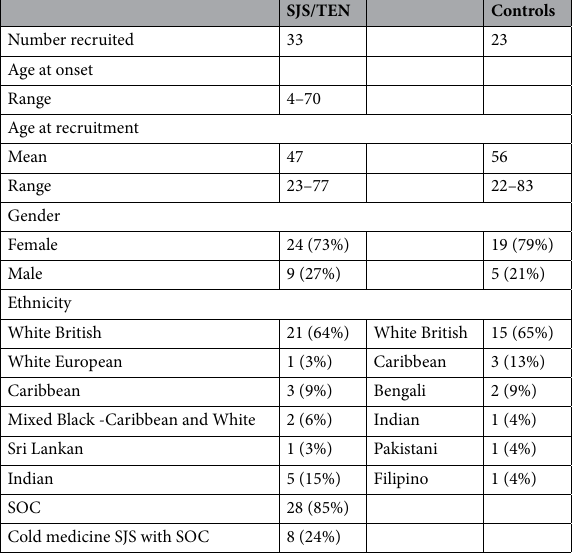
Table 1. SJS/TEN participant demographics. SJS/TEN Stevens–Johnson Syndrome/Toxic Epidermal Necrolysis, SOC severe ocular